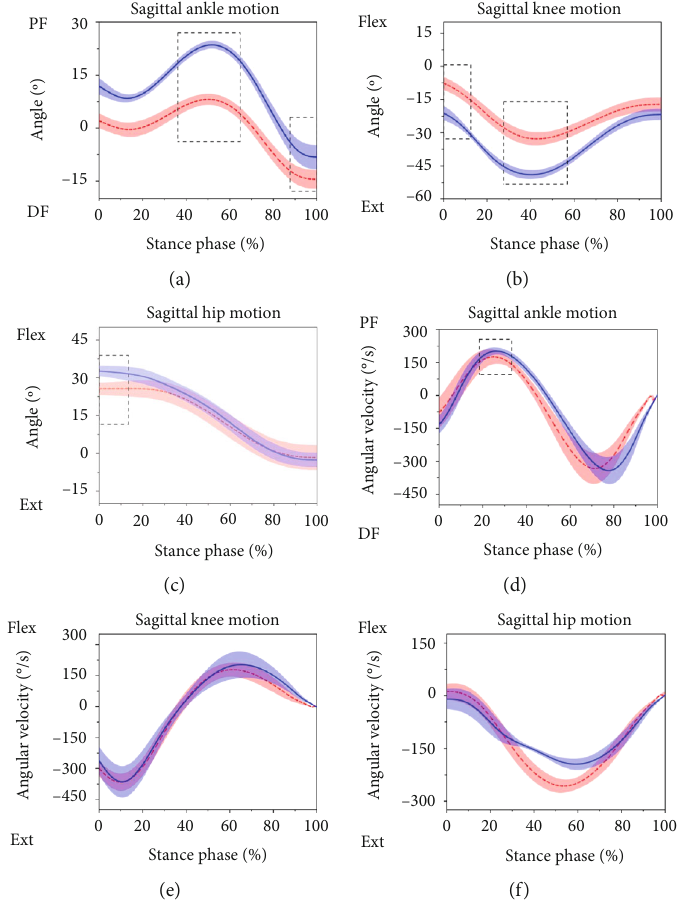
Figure 4: Sagittal ankle, knee, and hip joint kinematics for novice runners (the solid blue line is the mean and the shaded area is the standard deviation) and experienced runners (dashed red line is the mean). Note: the dotted box indicates a signi fi cant di ff erence between the two groups of runners, p < 0 : 05 . Table 4: Ankle, knee, and hip joint kinetics during the stance phase ( n = 24 ). Joint Variables Experienced Novice p value